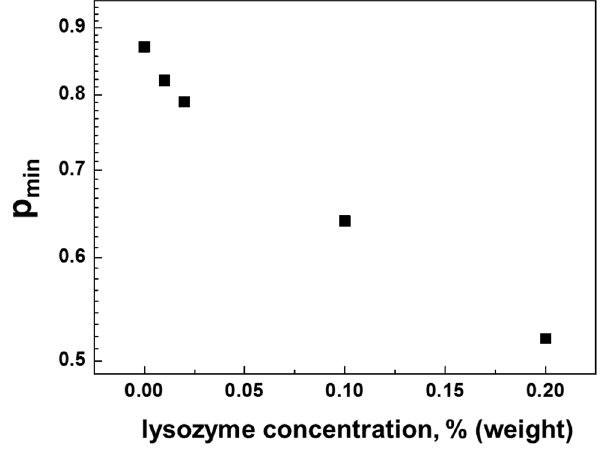
Figure 9. Population of molecules with self-diffusion coefficient having gel features in aqueous solutions of HA (0.75% weight) and HEWL mixtures as a function of protein content. The p min values were obtained from an analysis of the diffusion decays shown in Figure 8A obtained at a diffusion time of 50 ms.